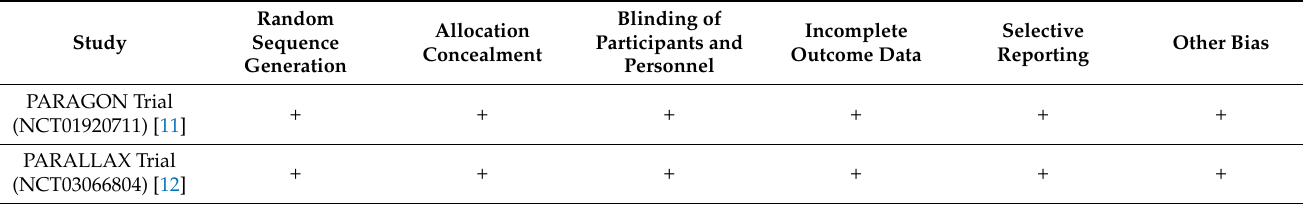
Table 1. The Cochrane tool for the quality assessment of clinical